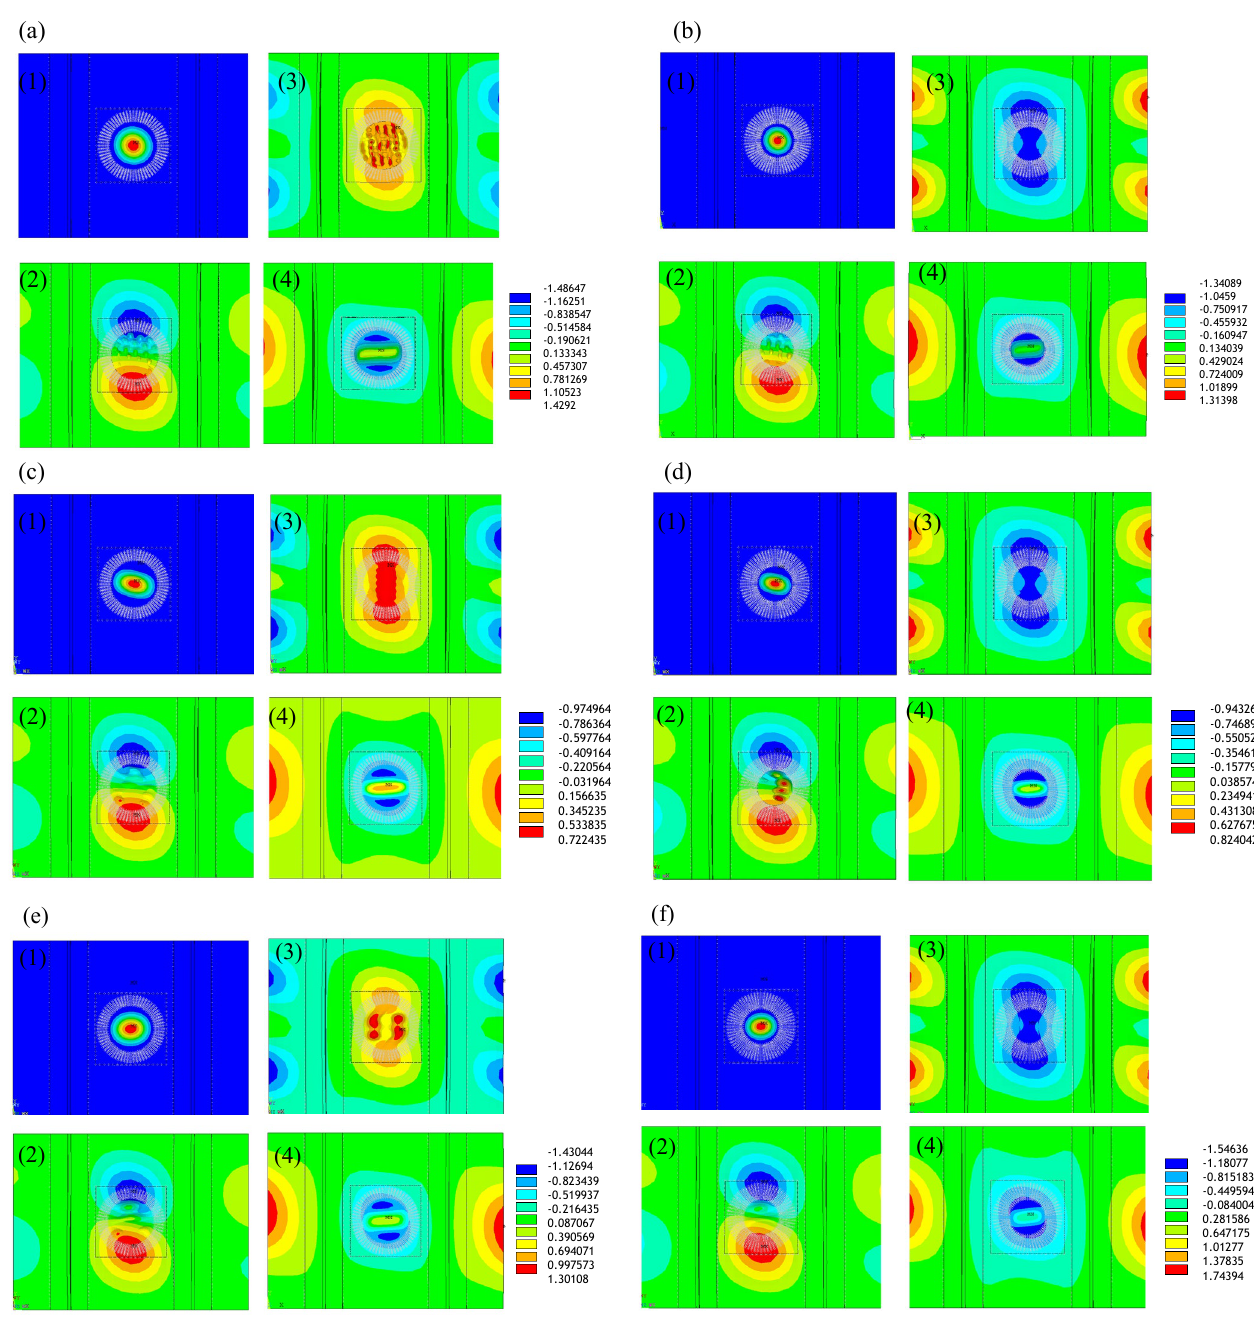
Figure 11. Out-of-plane displacement contour plot: (1) buckling of circular delamination, (2) buckling of the skin, (3) global buckling including stringers and (4) delamination initiation, with ( a ) CD11, ( b ) CD12, ( c ) CD13, ( d ) CD14, ( e ) CD15 and ( f ) CD16.